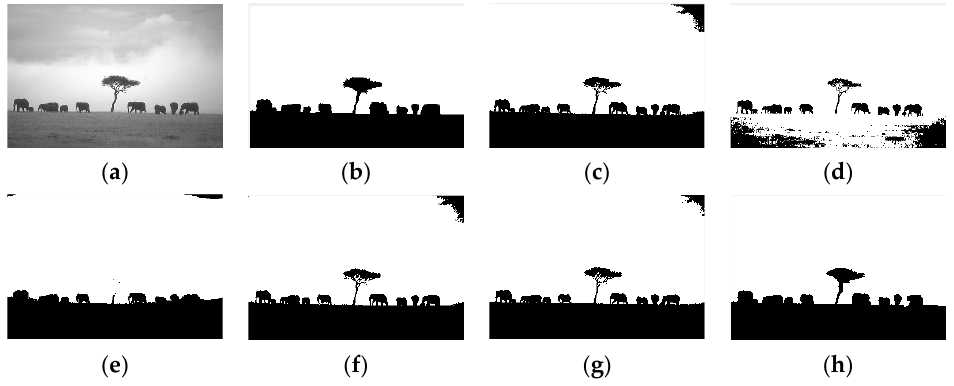
Figure 13. #227046 and its segmentations: ( a ) #227046, ( b ) ground-truth, ( c ) Otus, ( d ) MRCUT, ( e ) EITMIS, ( f ) NSWCC, ( g ) IT2FSWCC, ( h ) FSEFTISRI.